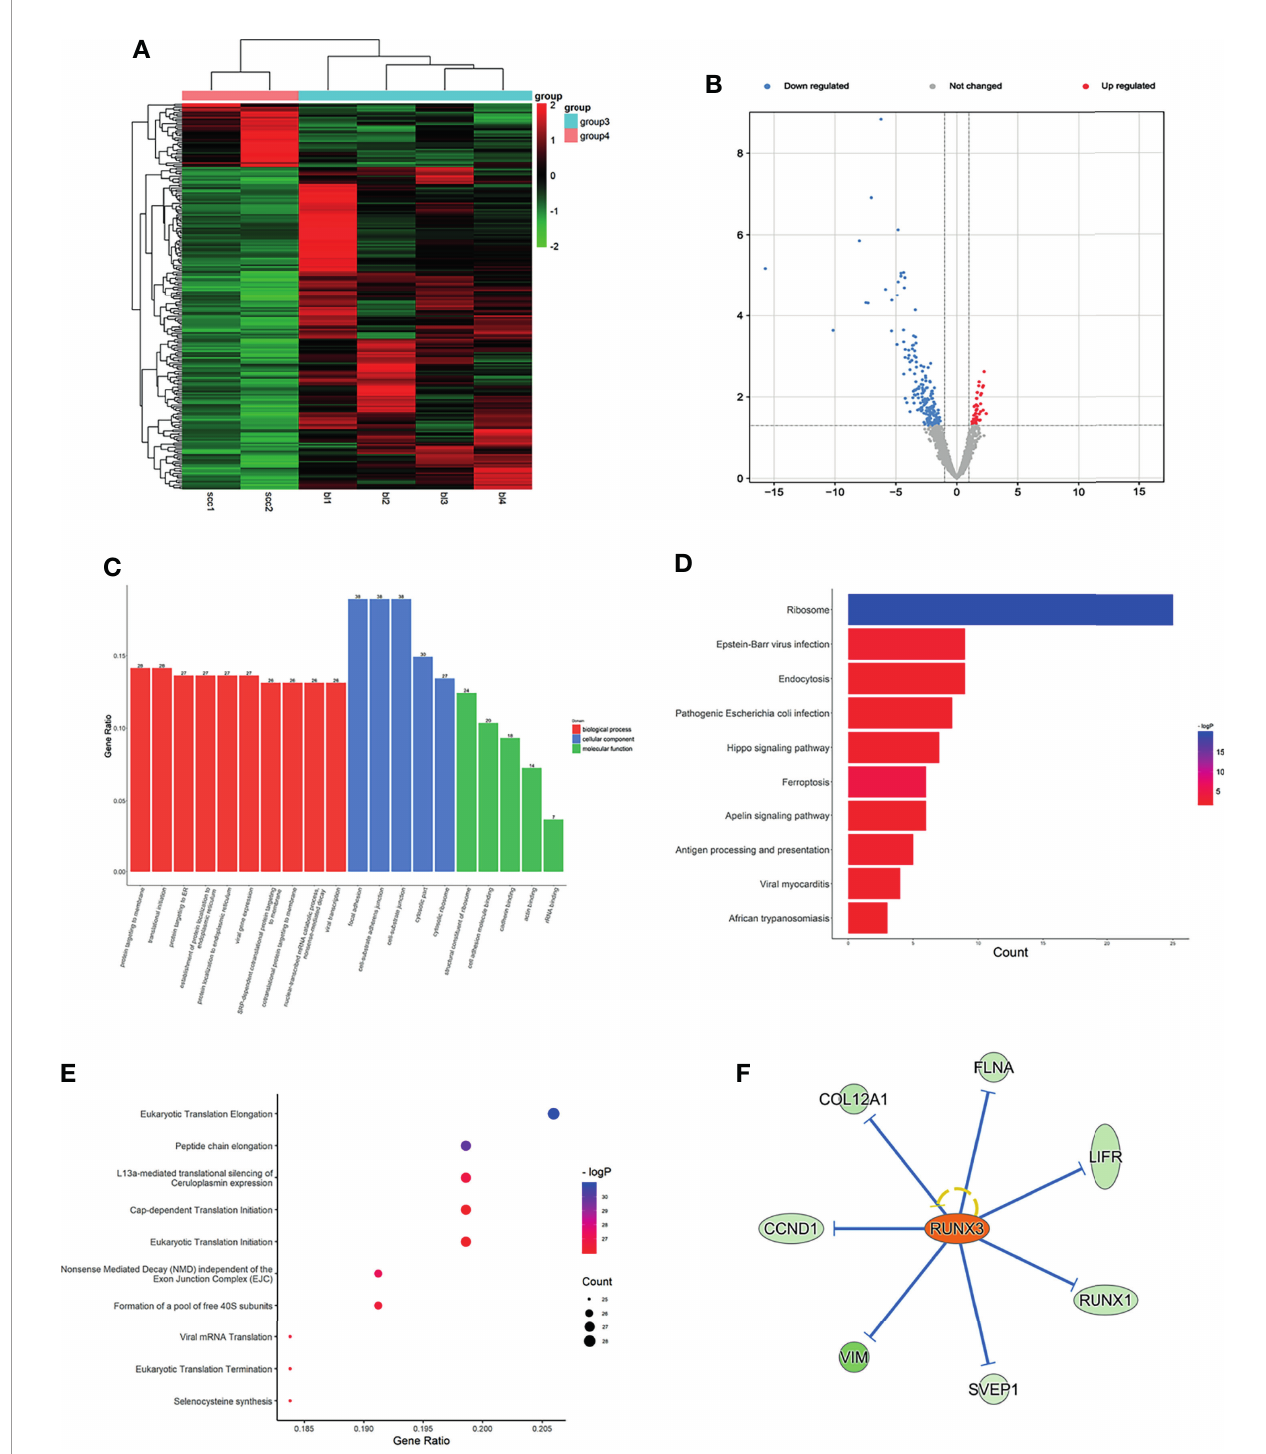
FIGURE 5 | Expression pro fi les of mRNAs in plasma between SCLC patients and LUH negative controls. (A) Heatmap of differentially expressed mRNAs in SCLC patients and controls (group 4, SCLC plasma; group 3, LUH plasma). (B) Volcano plot of differentially expressed mRNAs (read, upregulated genes; green, downregulated genes). (C) Enrichment analysis of GO terms and pathways of the differentially expressed mRNAs. (D) The top 10 KEGG terms for the differentially expressed mRNAs between two groups. (E) Reactome pathway analysis was performed to evaluate the underlying pathway. (F) Ingenuity pathway analysis predicted RUNX3 as a major activation of transcription regulator in